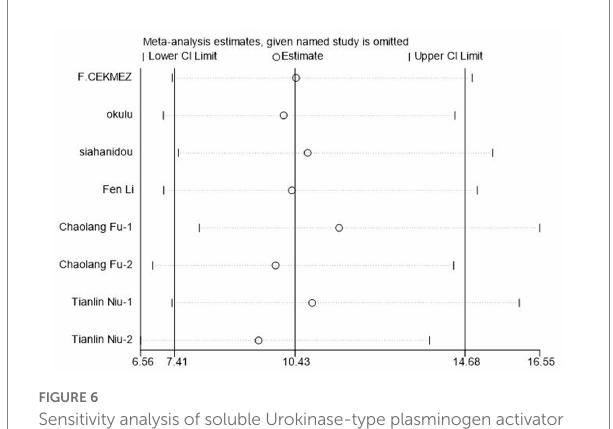
FIGURE 6 Sensitivity analysis of soluble Urokinase-type plasminogen activator receptor (suPAR) for neonatal sepsis diagnosis.